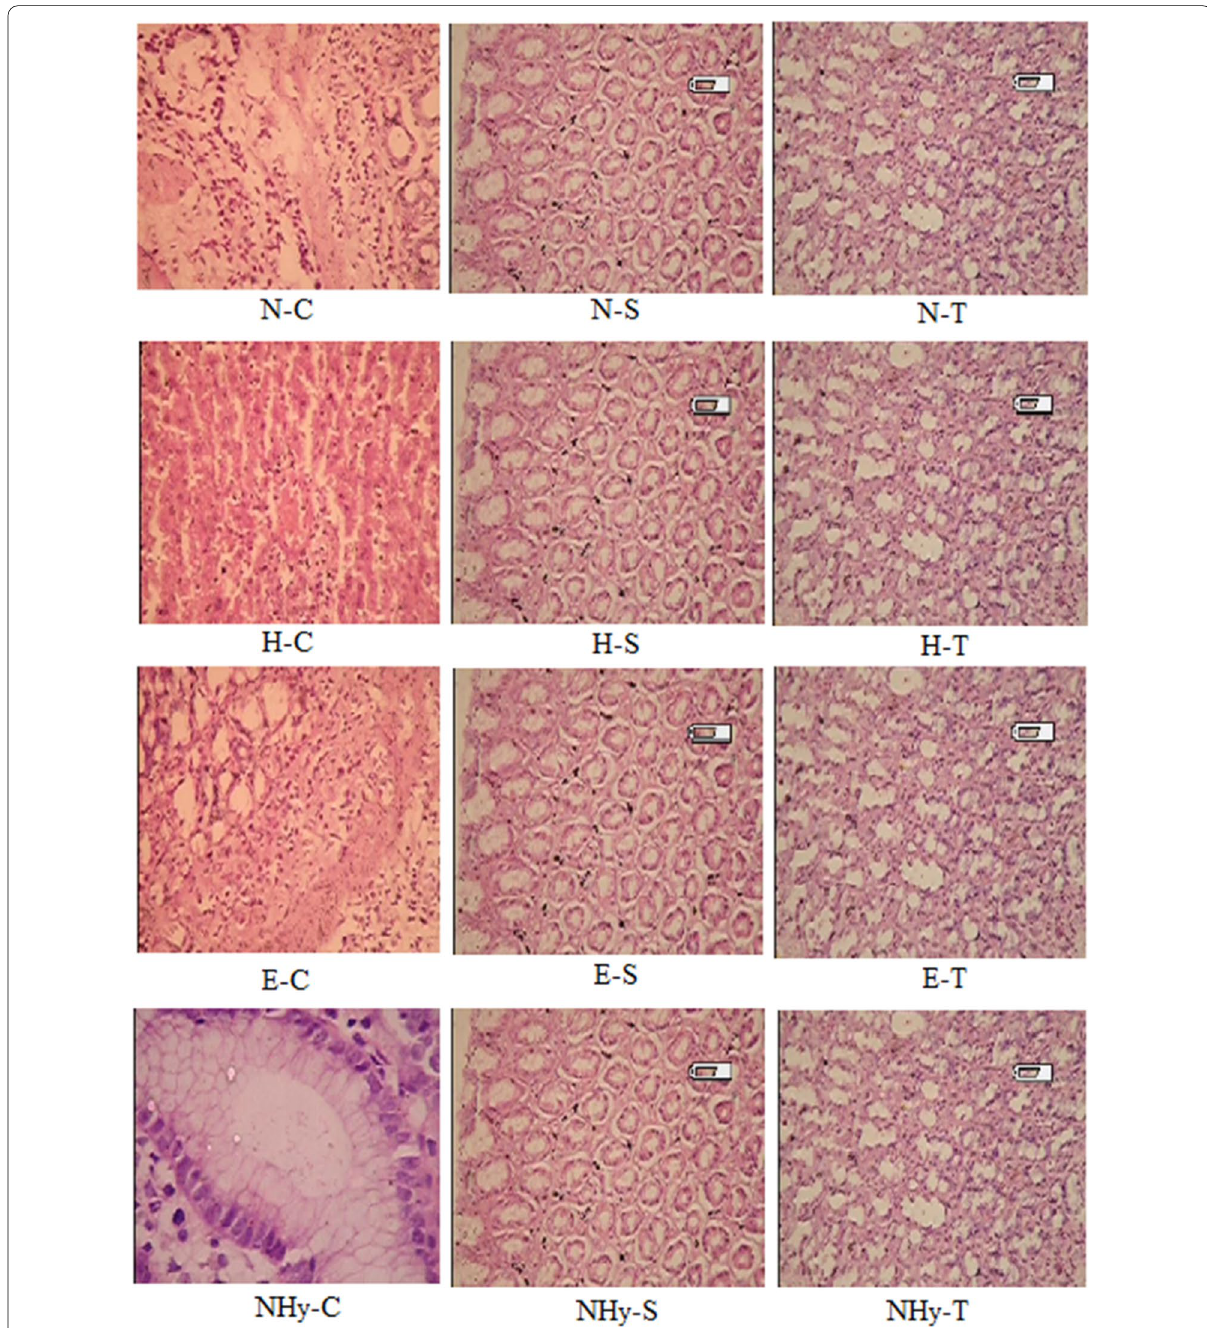
Fig. 4 Histopathological study of C. zeylanica extract-treated ulcers-induced animals models. N-C Naproxen-treated control group, N-S naproxen-treated standard group, N-T naproxen-treated test group, H-C histamine-treated control group, H-S histamine-treated standard group, H-T histamine-treated test group, E-C ethanol-treated control group, E-S ethanol-treated standard group, E-T ethanol-treated test group, NHy-C naproxen-induced H. pylori control group, NHy-S naproxen-induced H. pylori standard group, NHy-T naproxen-induced H. pylori test